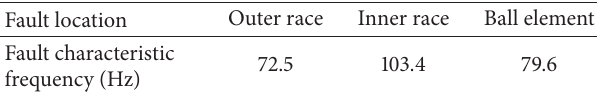
Table 1: Fault characteristic